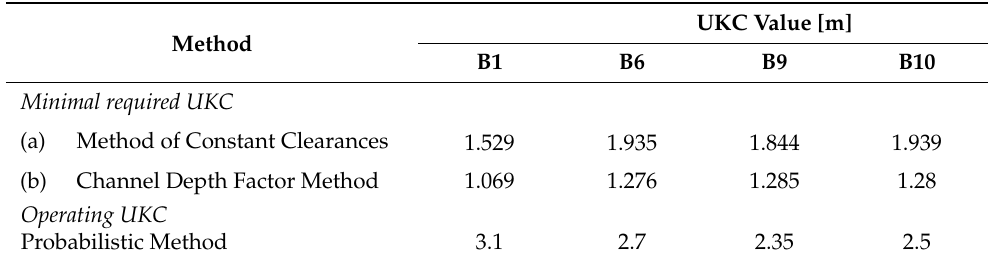
Table 5. Results for UKC calculation according to accessible methods for analysed bridge cross- sections of the Vistula